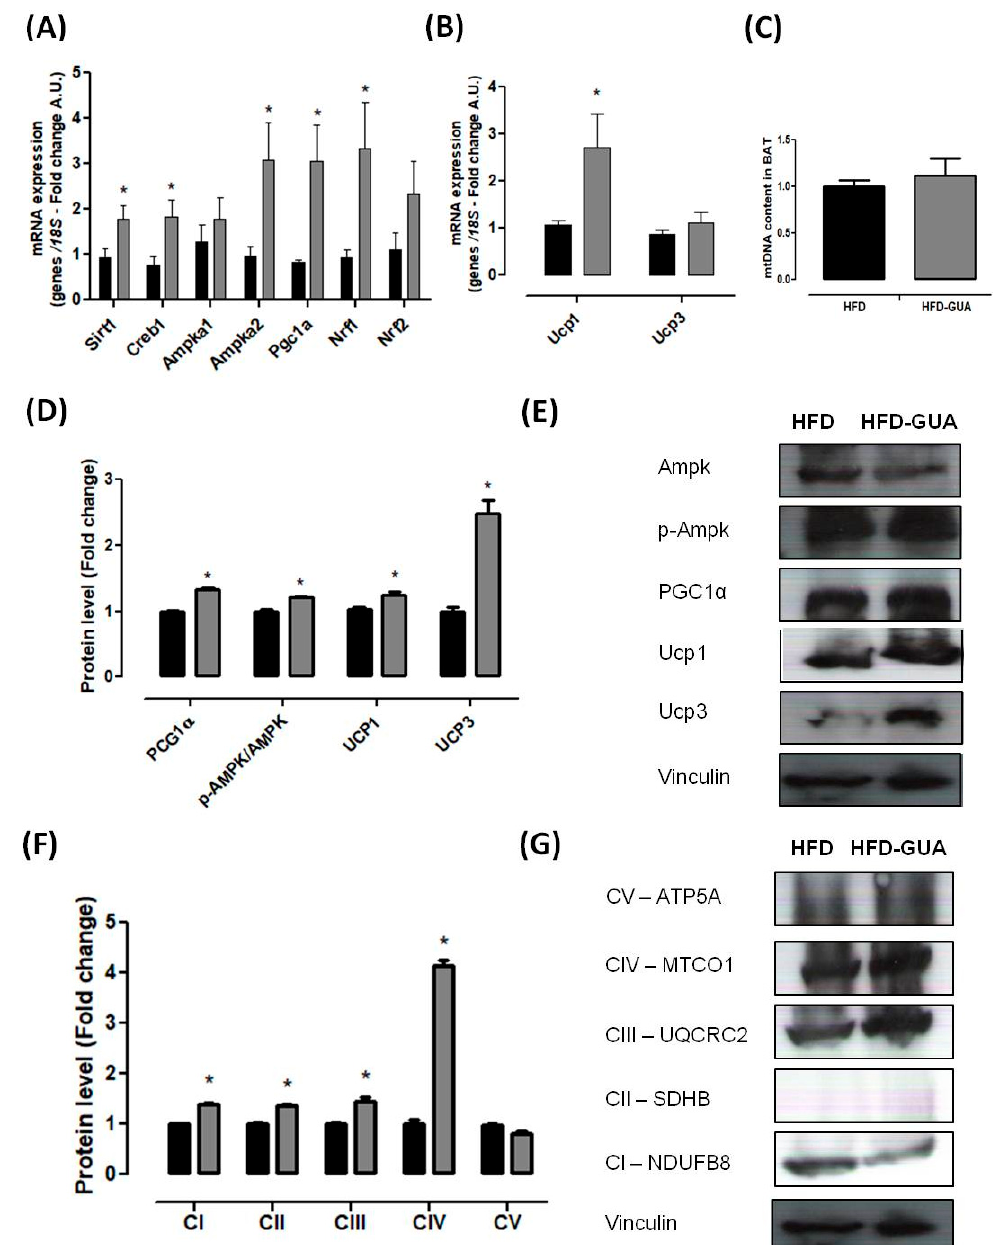
Figure 4. ( A ) Brown adipose tissue mRNA expression of Pgc1 α , Creb1 , Ampka1 , Ampka2 , Nrf1 , Nrf2 and Sirt1 after eight weeks of treatment; ( B ) Brown adipose tissue mRNA expression of Ucp1 and Ucp3 after eight weeks of treatment; ( C ) mtDNA quantification after eight weeks of treatment; ( D , E ) Brown adipose tissue protein level of Pgc1 α , p-Ampk/Ampk , Ucp1 and Ucp3 ; and illustrative images of protein content by western blotting; ( F , G ) Brown adipose tissue protein level of subunits of the five OXPHOS complexes and illustrative images of protein content by western blotting. All samples were normalized using housekeeping 18S gene and, afterwards, the HFD-GUA group was normalized by the HFD group. The equation 2 −ΔΔ C t was used to calculate the fold change. * p < 0.05 using Student’s t -test. Black bars correspond to the HFD-group ( n = 6) and grey bars correspond to the HFD-GUA group ( n = 6). Error bars reflect SEM.